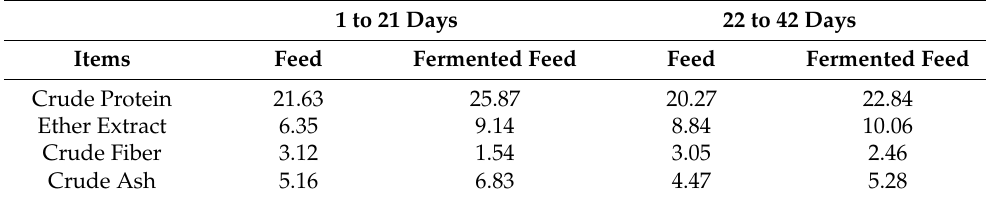
Table 2. Relevant nutritional tables of the plant fraction in broiler feed (air-dried basis) %. 1 to 21